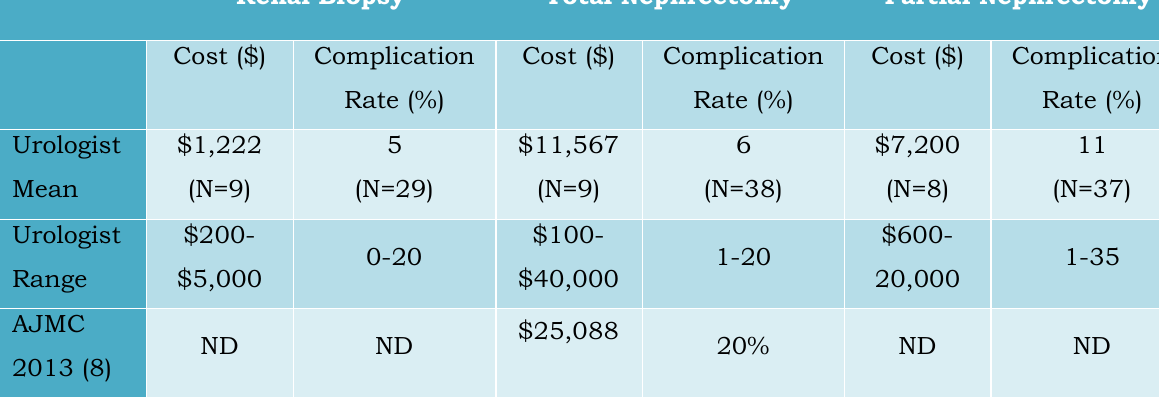
Table 3. Procedural costs and complication rates. Renal